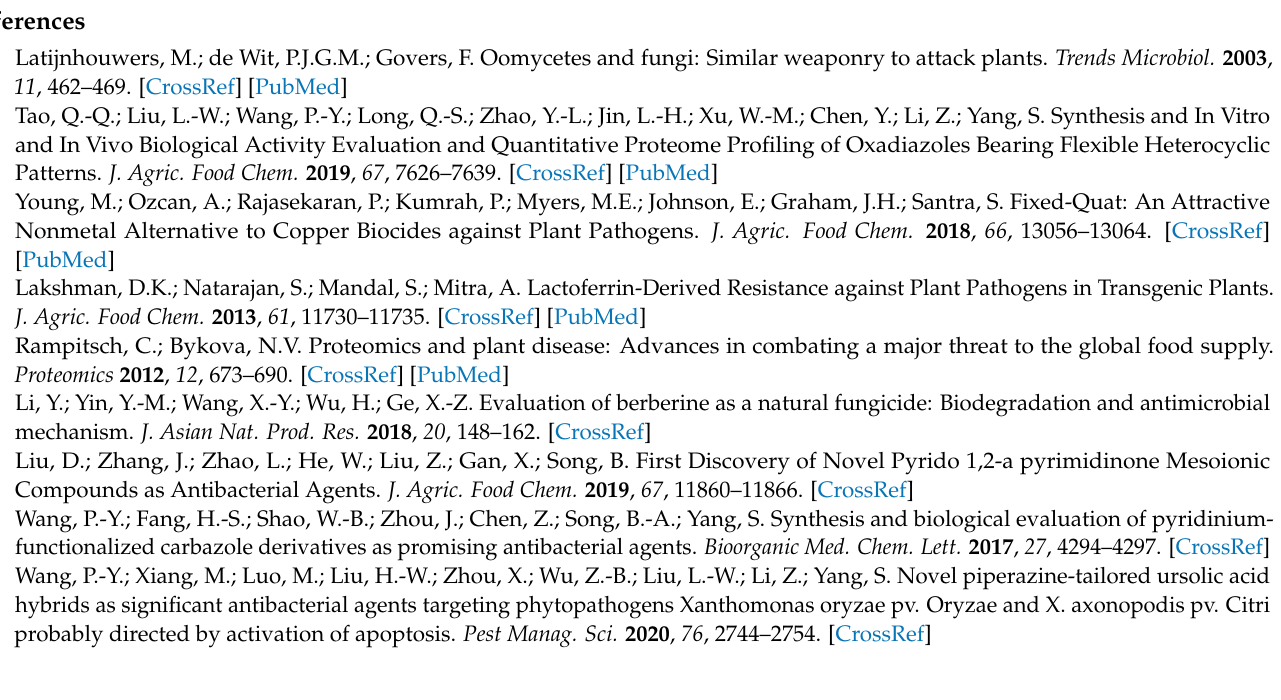
Figure S2: The chemical structures of